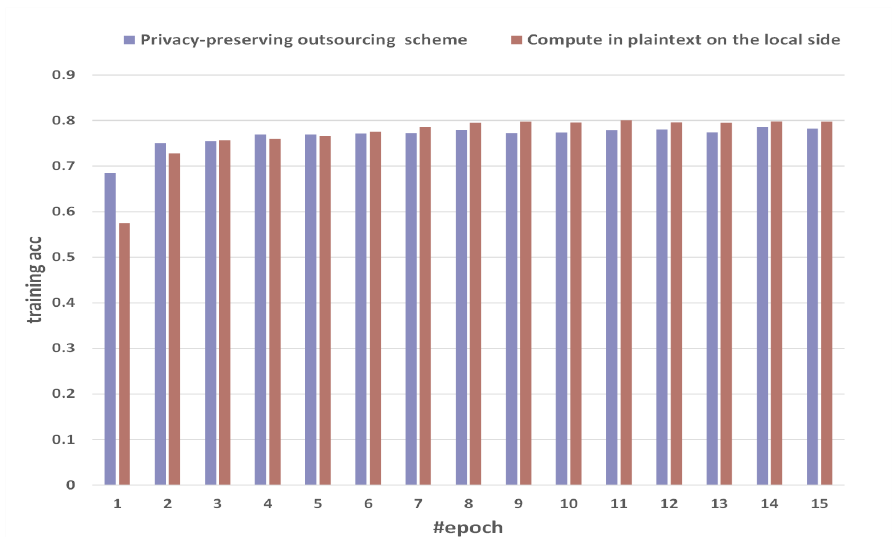
Figure 6. Comparison of training accuracy between the method of computing in plaintext on the local side and our scheme.